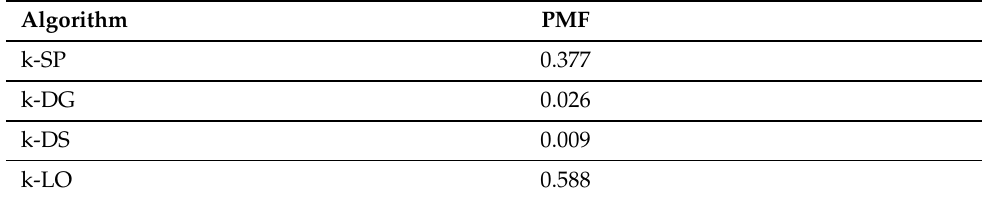
Table 1. PMF of Algorithms.